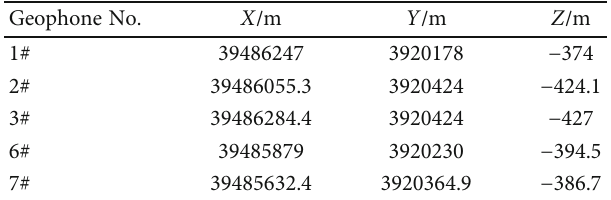
Figure 15: Location distribution of blasting source and geophones. Note: The green and black lines represent rock and coal roadways, respectively. Table 2: Three-dimensional coordinates of 1#, 2#, 3#, 6#, and 7# geophones.